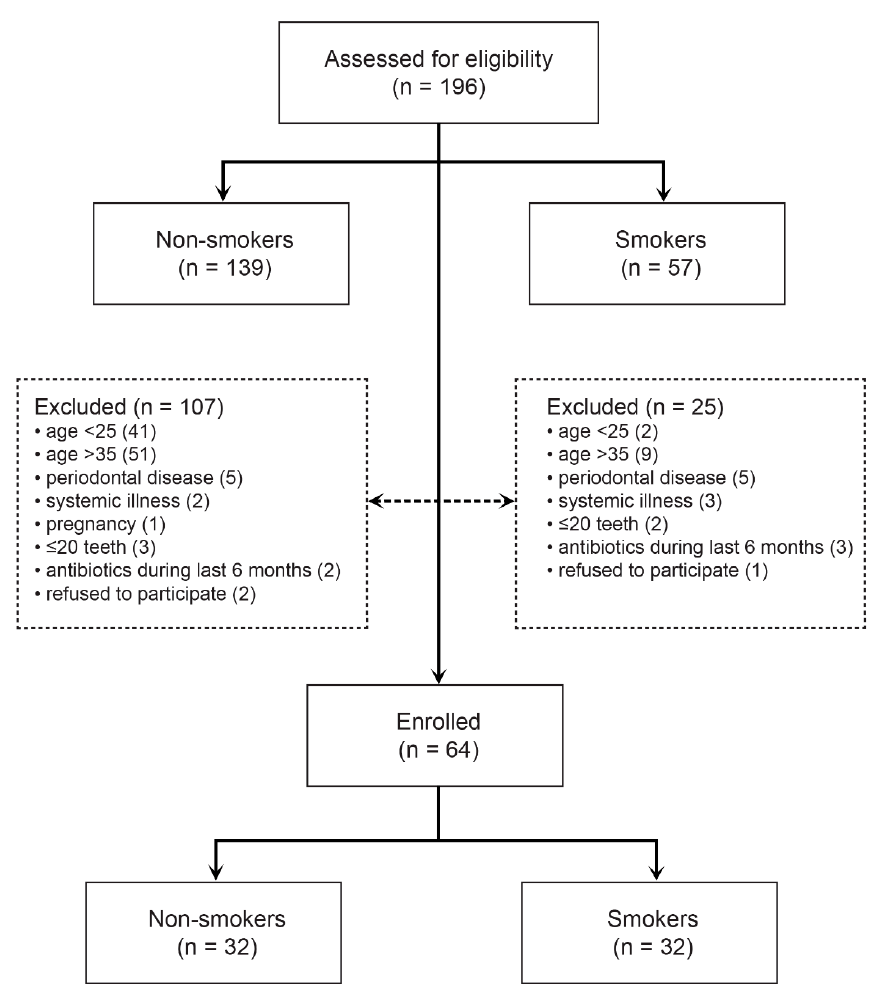
Figure 1. Study flow.